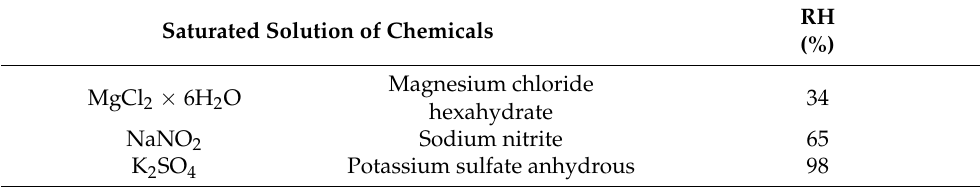
Table 1. Saturated solutions of chemicals used to obtain appropriate relative humidity